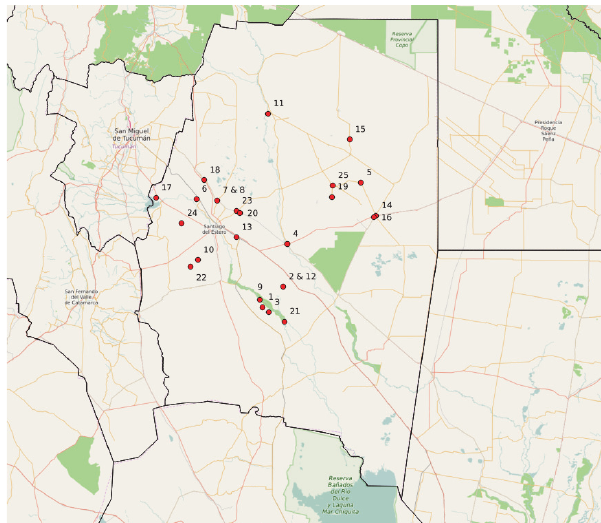
Figure 1: Acute cases place of residence.